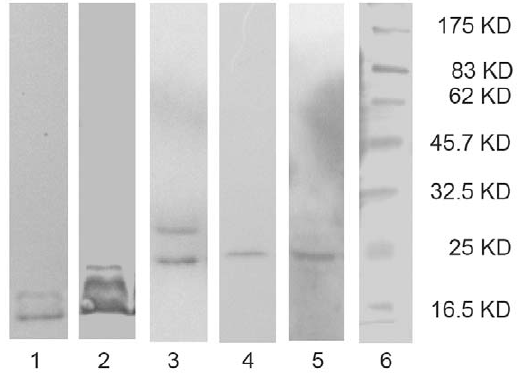
Figure 2. Protein antigens are detected by Western blot analysis. E. coli O157:H7 cell lysates were subjected to SDS–PAGE, transferred to nitrocellulose filter, and probed with 1C6 (lane 1), 1D8, (lane 2), 4A7 (lane 3), 5A2 (lane 4), 5D8 (lane 5). The sizes of molecular weight standards are shown at the right (lane 6).